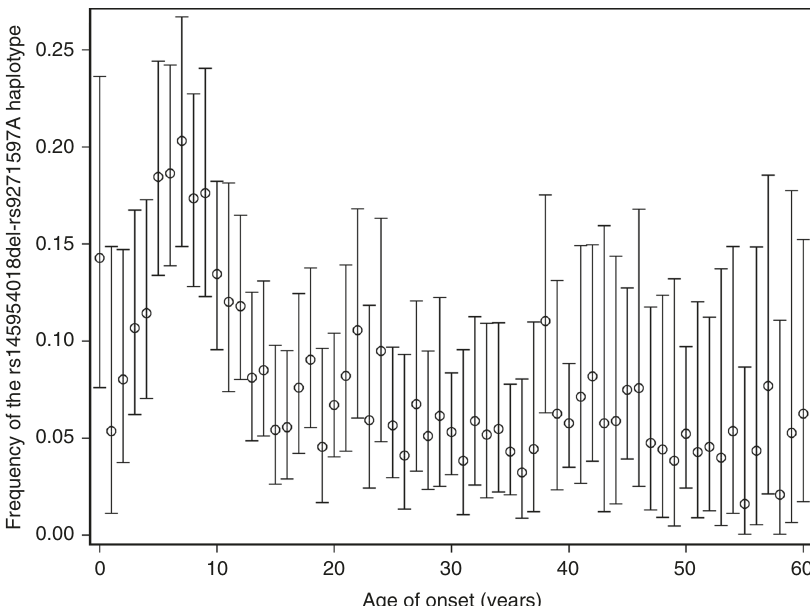
Fig. 3 rs1459540del-rs9271597A haplotype frequency across vitiligo age-of-onset. Frequency of the rs145954018del-rs9271597A high-risk haplotype in 4,254 vitiligo cases is shown in 1-year age-of-onset intervals. Circles indicate means and bars 95% con fi dence intervals, calculated using the binom.test function in R. Note that only cases with age-of-onset < 60 years were used to make the fi gure, as beyond age-of-onset 60 years the number of cases in each 1-year interval is too small to give reliable estimates of means and 95% con fi dence intervals. Source data are provided as a Source Data fi